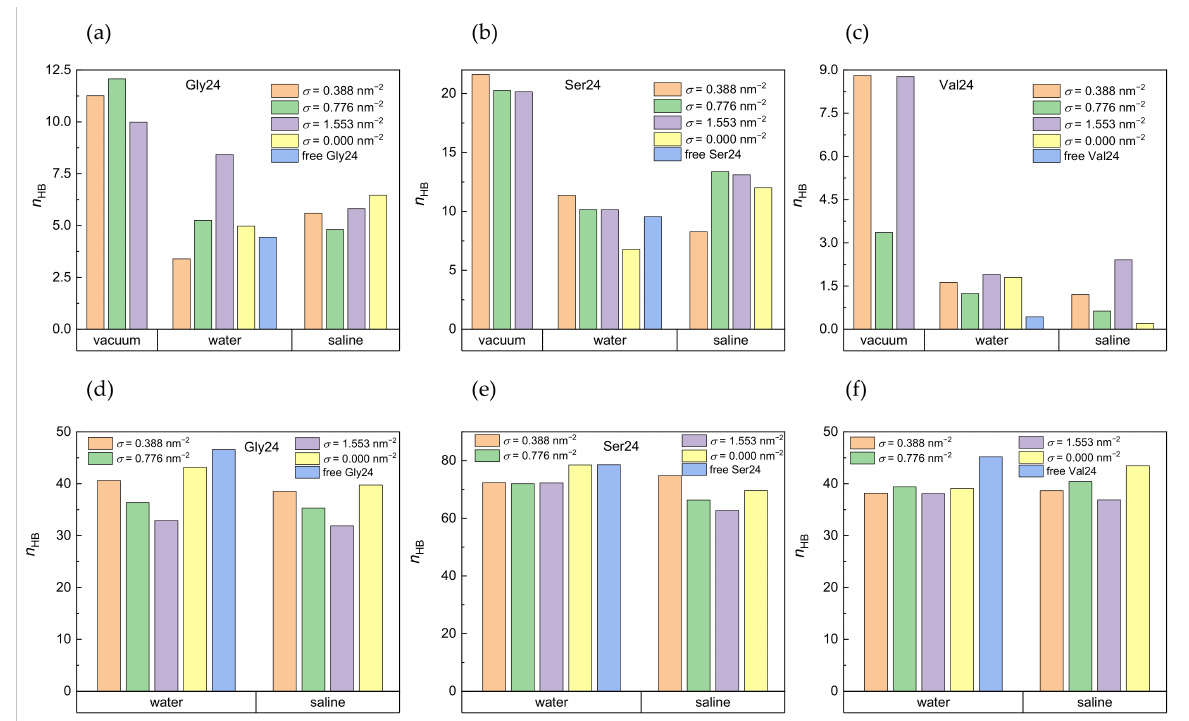
Figure 5. Number of intramolecular hydrogen bonds in polyglycine ( a ), polyserine ( b ), and polyvaline ( c ) in a vacuum, water, and saline and number of hydrogen bonds formed by water molecules with polyglycine ( d ), polyserine ( e ), and polyvaline ( f ) in water and saline in systems with different grafting densities. For comparison, the number of hydrogen bonds for the free peptides and the peptides adsorbed on pristine CNT are also included. Standard deviations are in the range of 5–12% of the average